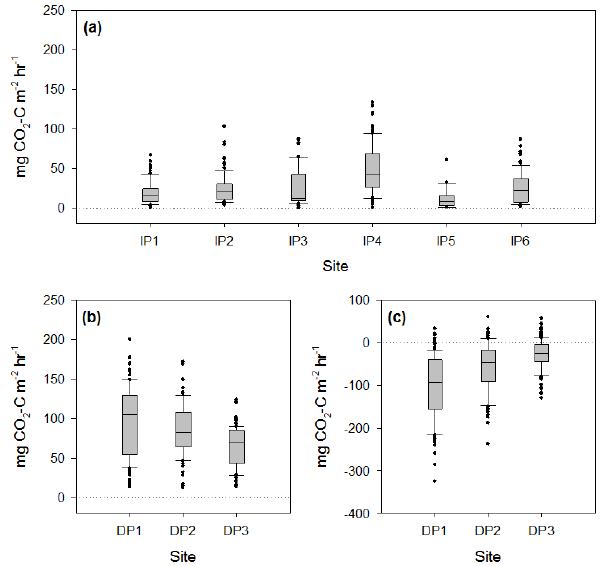
Figure 3. (a) Ecosystem respiration ( R eco ;mgCO 2 -Cm − 2 hr − 1 ) at sites IP1–6, (b) R eco (mgCO 2 -Cm − 2 hr − 1 ) at sites DP1–3 and (c) net ecosystem exchange (NEE;mgCO 2 -Cm − 2 hr − 1 ) when PPFD>1000µmolm − 2 s − 1 at sites DP1–3. Positive values indicate CO 2 -C flux from the peatland to the atmosphere (source) and nega- tive values indicate CO 2 -C flux from the atmosphere to the peatland (sink). The 10th and 90th percentile are indicated by the bars, the 25th and 75th percentiles with the top and bottom of the box and the median value by the centre line.